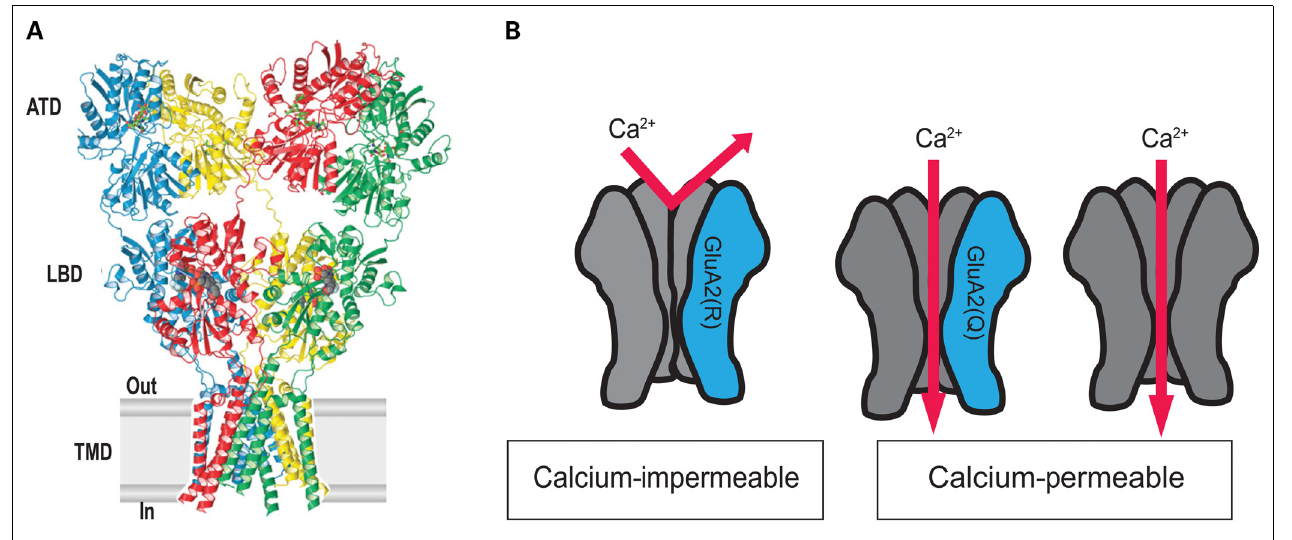
FIGURE 2 |AMPA receptors containing GluA2 are Ca 2 + -impermeable due to editing at the Q/R site. (A) Current understanding of the quaternary structure of AMPA receptors, thought to be tetrameric assemblies of four AMPA receptor subunits form the ion channel pore.The assembled receptor can comprise any combination of GluA1–GluA4 subunits but usually contains